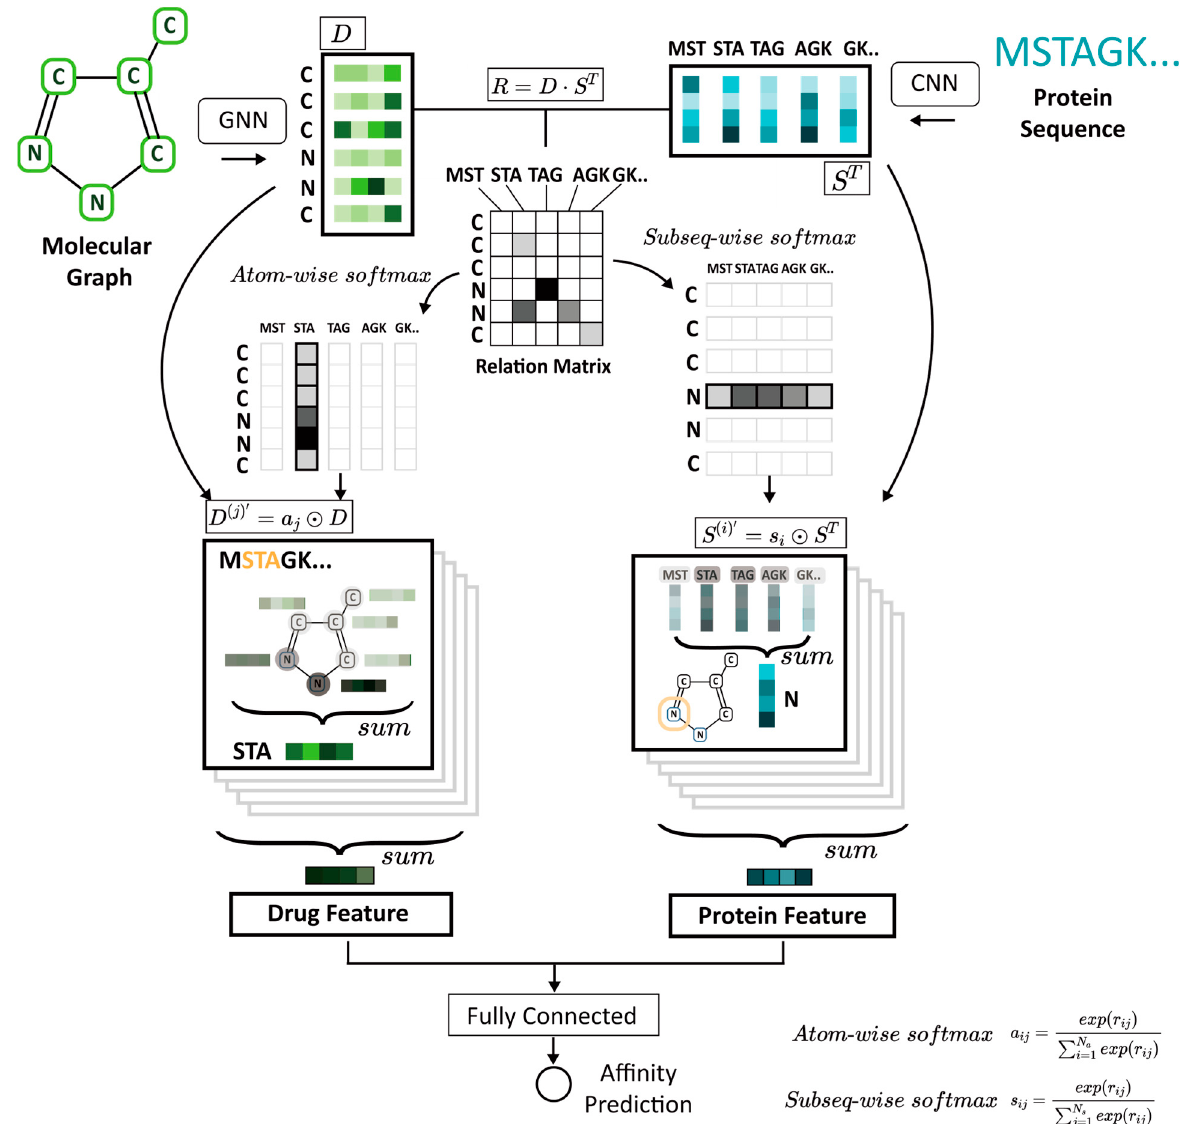
Figure 1. GraphATT-DTA architecture. Molecule graph and protein amino acid sequences are taken as input, and the predicted binding affinity of drug-target pair is the output. The attention-based novel representation is learned by molecule encoding with a graph neural network, sequence encoding using convolutional neural networks, and interaction modeling. The local-to-global relationships between drug substructures and protein sub-sequences are learned via interaction modeling using an attention mechanism. CNN, convolutional neural network; GNN, graph neural network; D, drug embedding matrix; S, protein embedding matrix; R, relation matrix; a, atom-wise softmax of relation matrix; s, subseq-wise softmax of relation matrix.